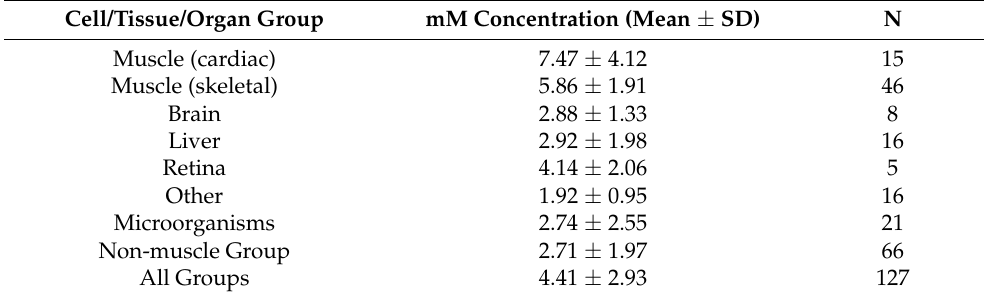
Table 2. ATP concentrations in normal cells/tissues/organs computed from Table S1 (means ±